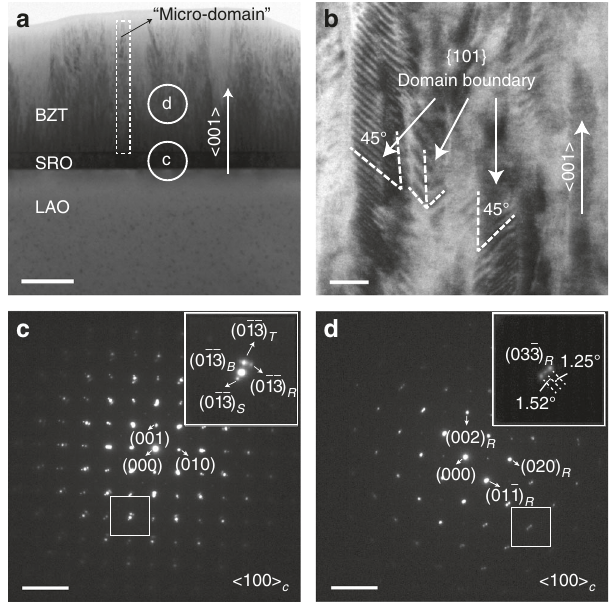
Fig. 2 Transmission electron microscopy (TEM) analysis. a , b Cross- sectional TEM images of a 0.7- μ m-thick BZT fi lm (scale bar: 200 nm for a and 20 nm for b ), and c , d SAED patterns (scale bar: 5 nm − 1 ) for the areas marked in a . Subscripts T and R denote the T and R phases of the fi lm, while B and S represent the bottom electrode and the substrate